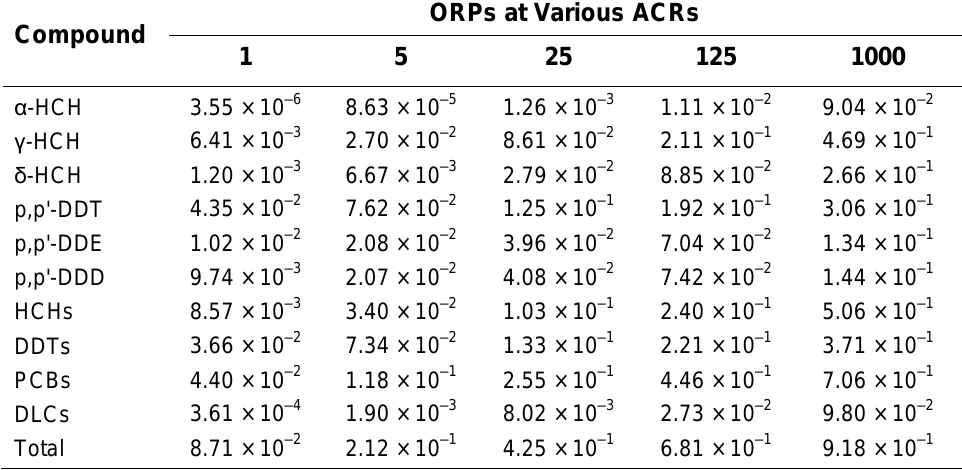
ORPs Calculated from